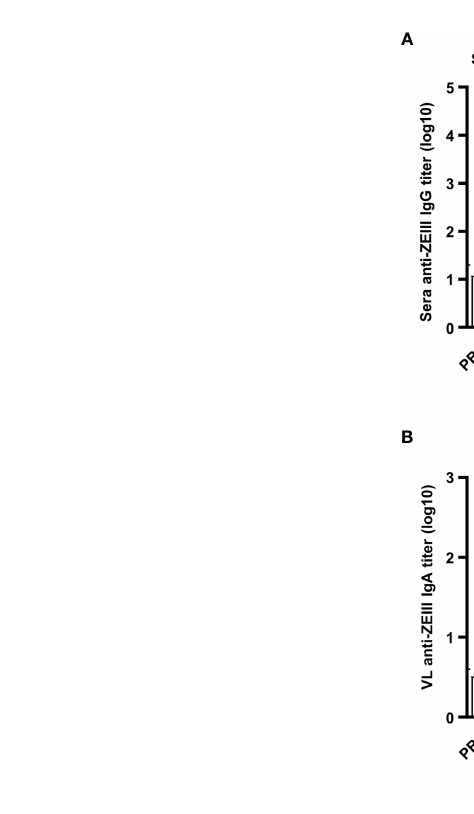
FIGURE 5 | Antibody responses induced by intranasal administration of rZEIII-FLIPr. Immunode fi cient AG129 mice (n=9/group) were vaccinated three times with PBS, rZEIII, or rZEIII-FLIPr (30 m g per dose) via the intranasal route at two-week intervals. Serum and VL samples were collected from vaccinated mice 6 weeks after the fi rst vaccination. (A) The titers of anti-rZEIII IgG and IgA antibodies in the serum were determined by ELISA. (B) The titers of anti-rZEIII IgA antibodies in VL were determined by ELISA. (C) The Zika virus-neutralizing capacity of the serum samples was determined by FRNT. The neutralizing antibody titer was de fi ned as the reciprocal of the highest dilution that resulted in a 50% reduction in FFUs compared to the FFUs of control samples containing the virus alone. Data represent the mean ± SE of a total of 9 mice per group, which were pooled from 2 independent experiments. The detection limit is indicated by the dotted line on the y-axis, which indicates the initial dilution factor of the sample. Statistical signi fi cance was determined using the Kruskal-Wallis test with Dunn ’ s multiple comparison test.